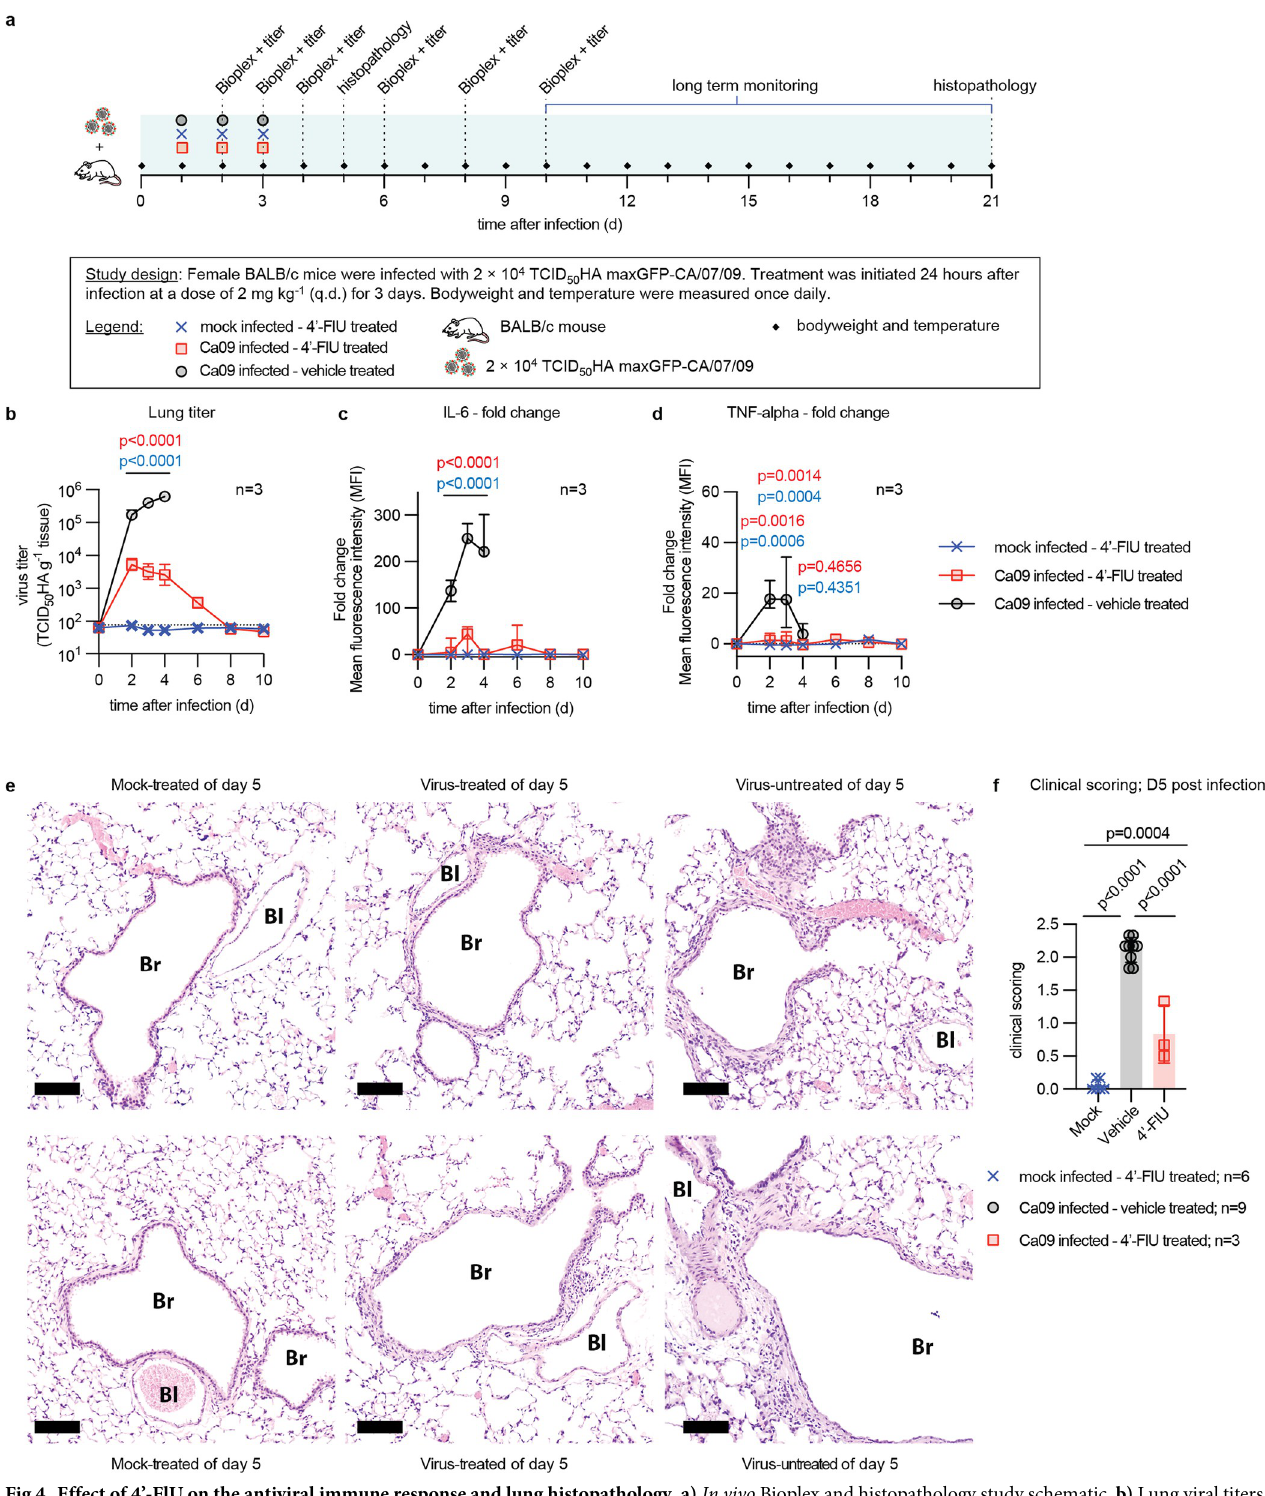
Fig 4. Effect of 4’-FlU on the antiviral immune response and lung histopathology. a) In vivo Bioplex and histopathology study schematic. b) Lung viral titers in animals treated as in (a). c-d) Changes in IL-6 (c) and TNF- α (d) levels present in BALF of animals treated as in (a), relative to levels at time of infection. Lines in (b) intersect, and symbols show, geometric means ± SD, lines in (c-d) intersect, and symbols show, data medians with 95% CI; 2-way ANOVA with Tukey’s post hoc test; P values are given. e) Representative photomicrographs of lung tissue extracted 5 days after infection of animals treated as in (a).